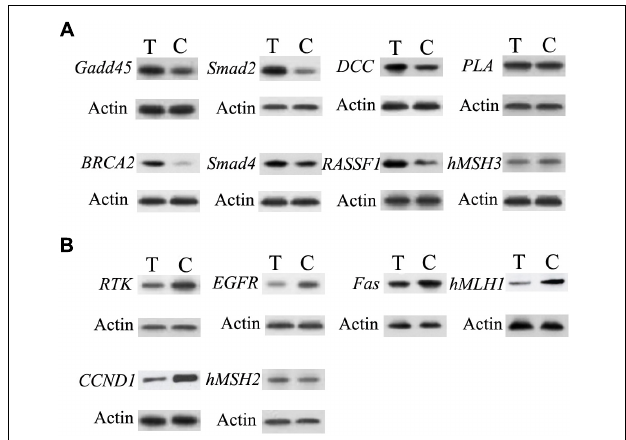
FIGURE 5 | Validation of the difference in expression of the genes by western blot. (A) The western blot results of the up-regulated genes in infected group. (B) The western blot results of the down-regulated genes in infected group. C, control group; T, treated group.